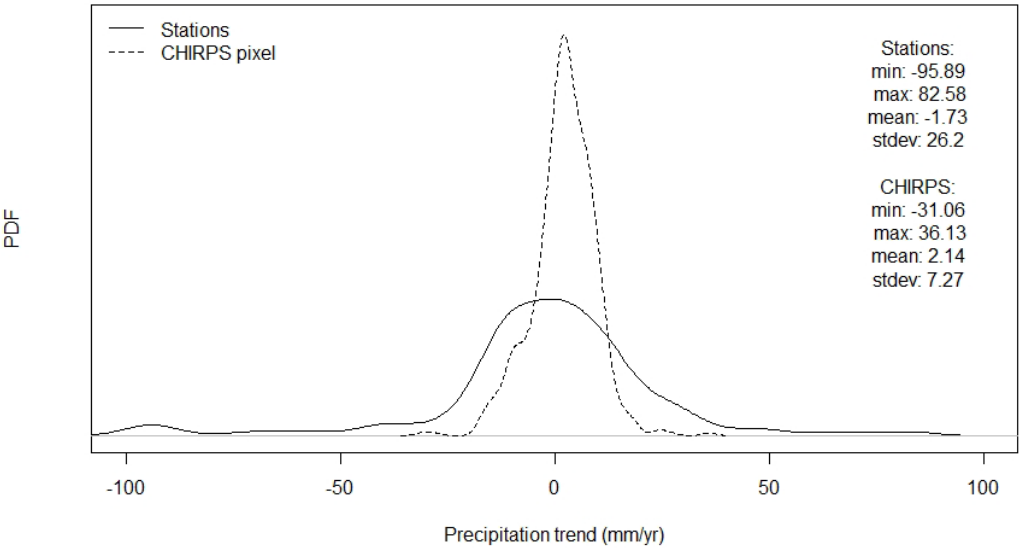
Figure 7. Probability density function (PDF) comparison between the 20-year time series from the in situ stations and the CHIRPS per single pixel with stations.